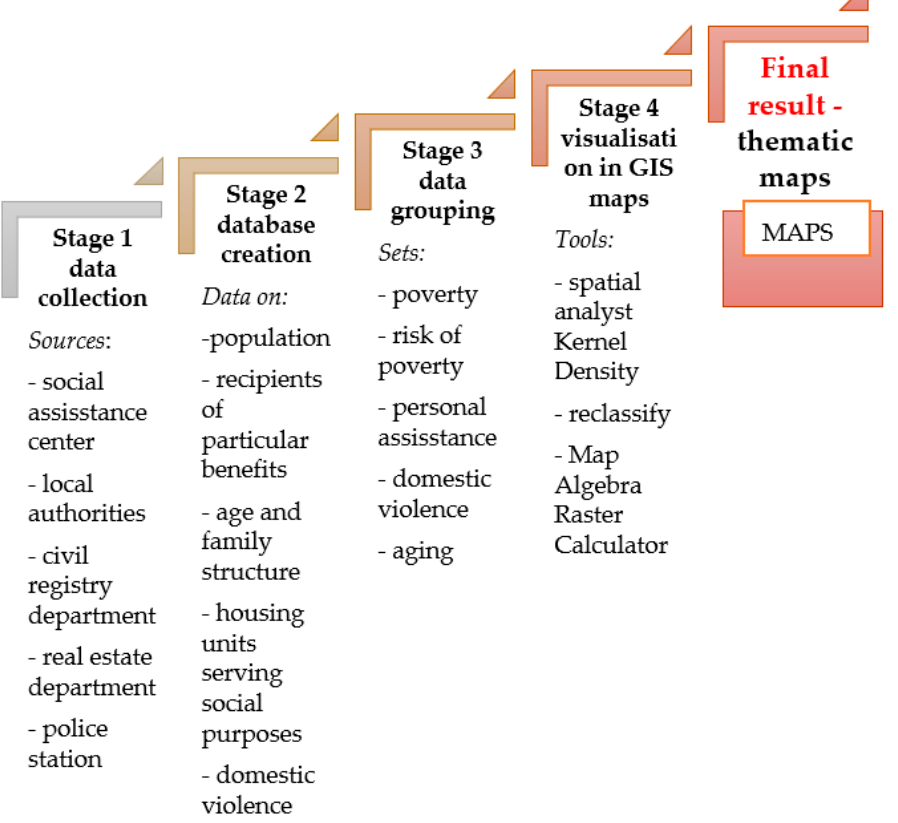
Figure 1. Research design algorithm . Source: Own elaboration.